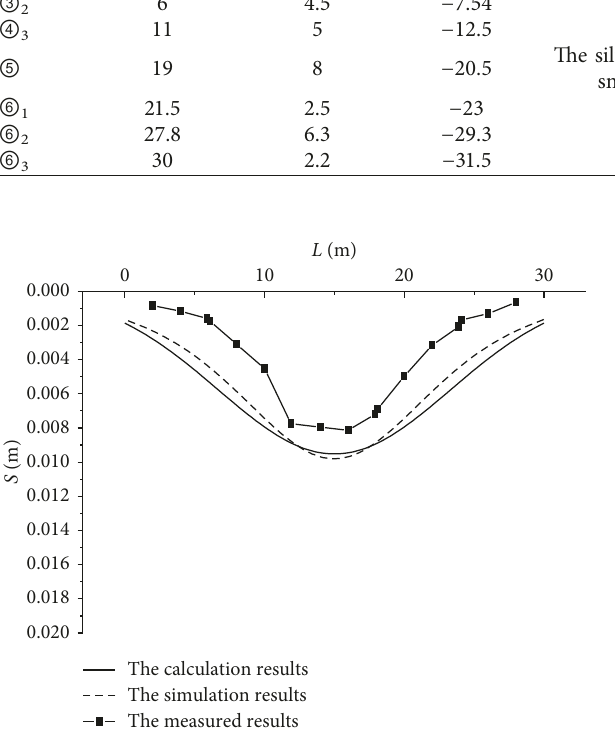
Figure 10: Comparison of measured settlement and finite element method and formula calculation.